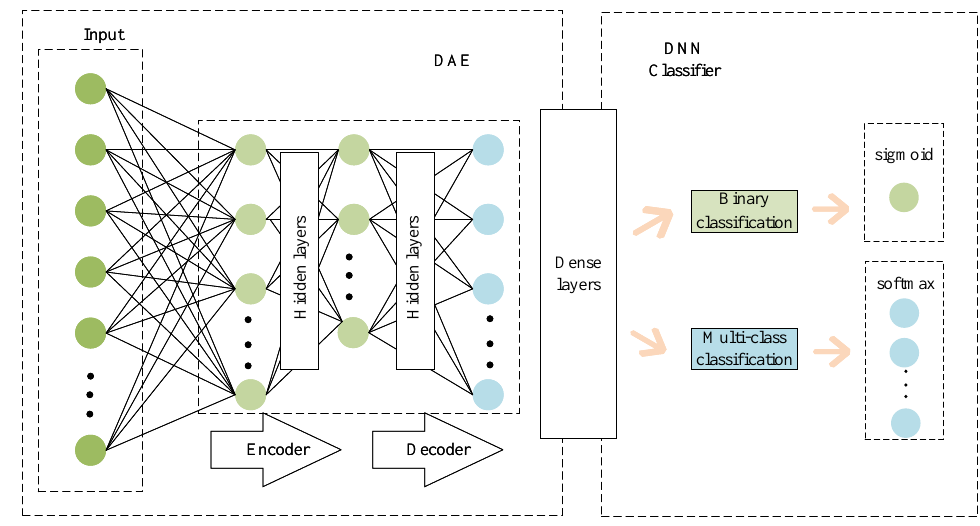
Figure 8. A classification model combining DNN and